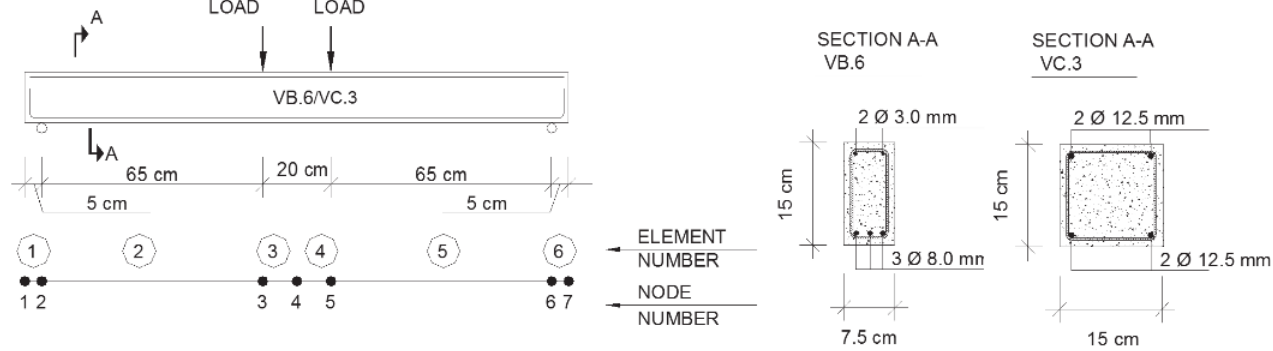
Tested beams (VB6/VC3) geometry and reinforcement; load application and support positions (Juvandes [30])